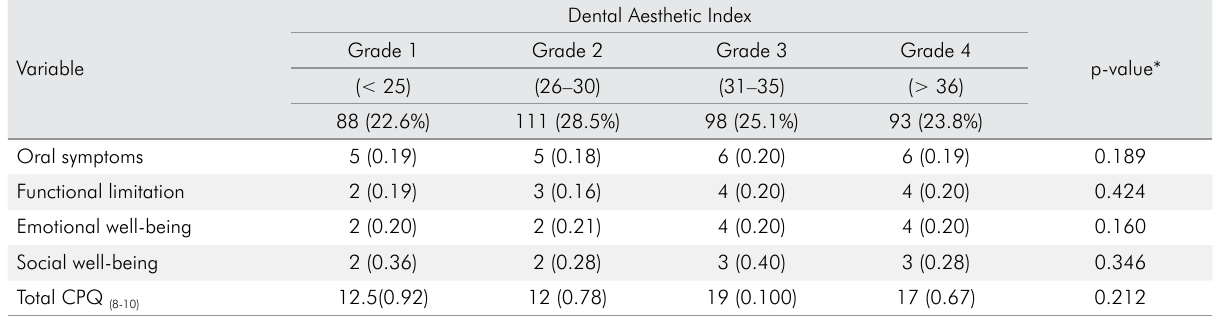
total and subscale (n = 390) scores; Diamantina, Brazil, 2013. (8-10)